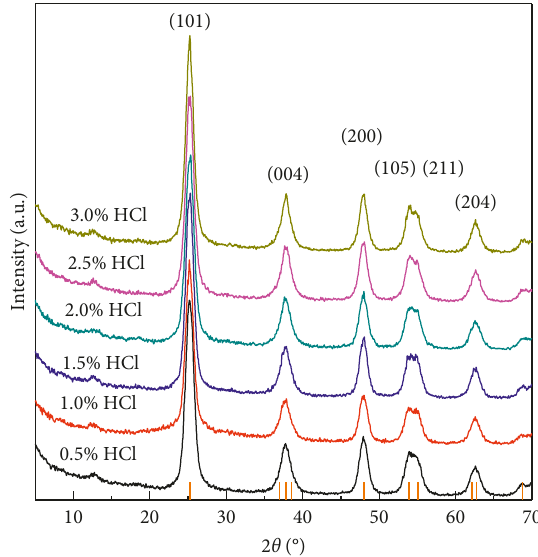
Figure 2: X-ray diffraction patterns of TiO 2m nanoparticles pre- pared at 200 ° C in an autoclave as a function of HCl concentration.